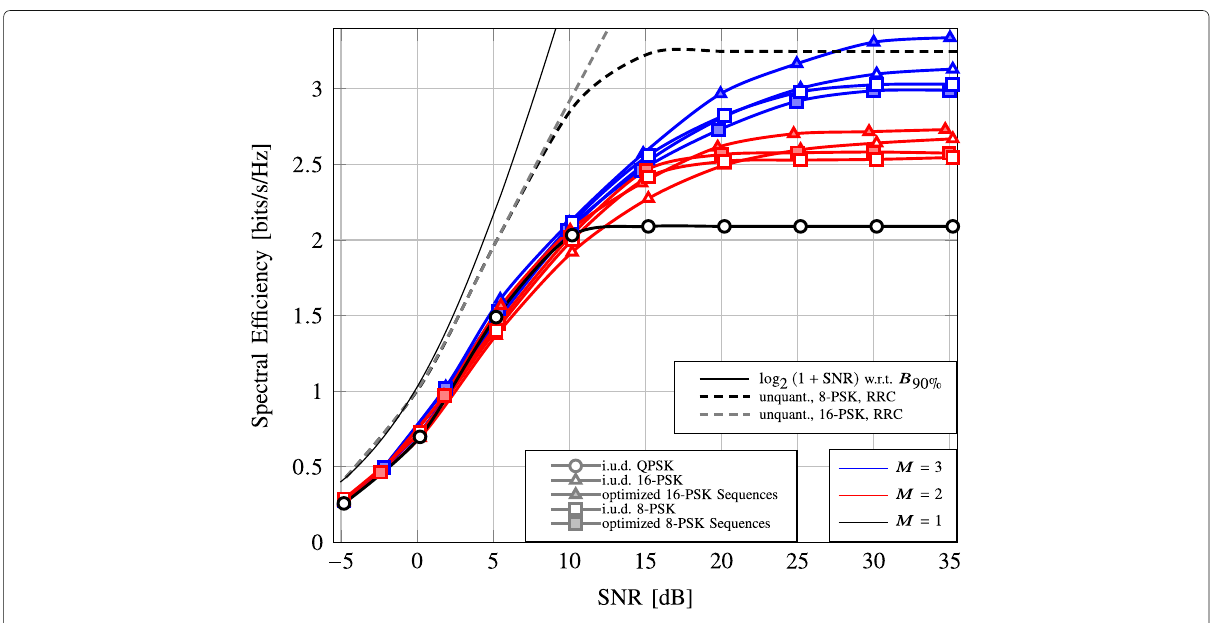
Fig. 14 Spectral efficiency ( B 90% ) versus SNR considering PSK transmit